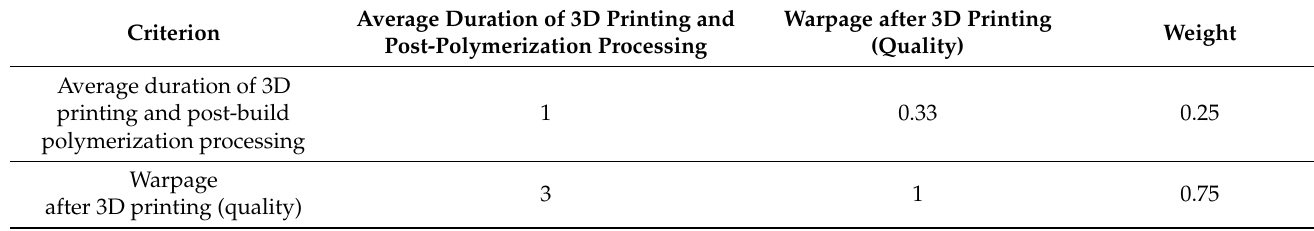
Table 12. The data on the paired comparison and the weights. Technological